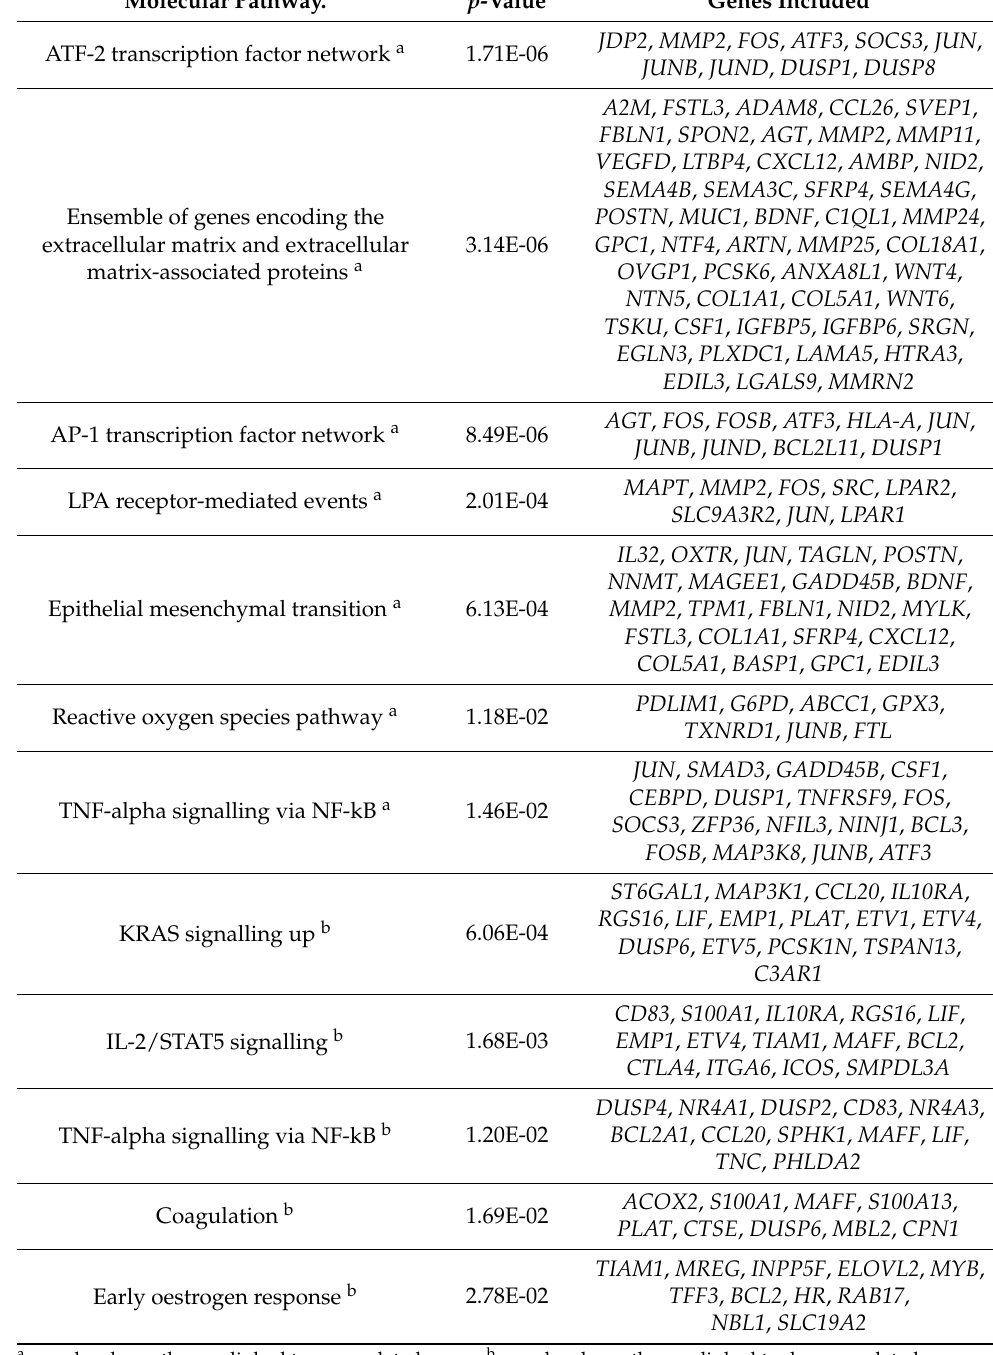
Table 4. Molecular pathways associated with differentially expressed genes. Molecular